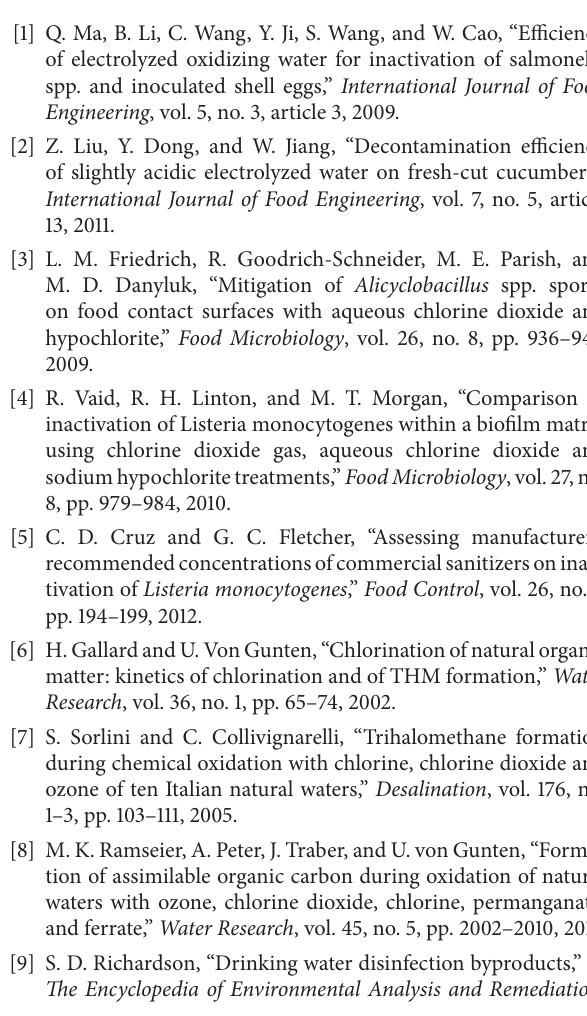
Table 6: Total trihalomethane (THM) residuals by GC/MS. Item Total trihalomethane a (ppb) Methyl chloride ND Dichloromethane ND Chloroform ND a The instrument detection limit was